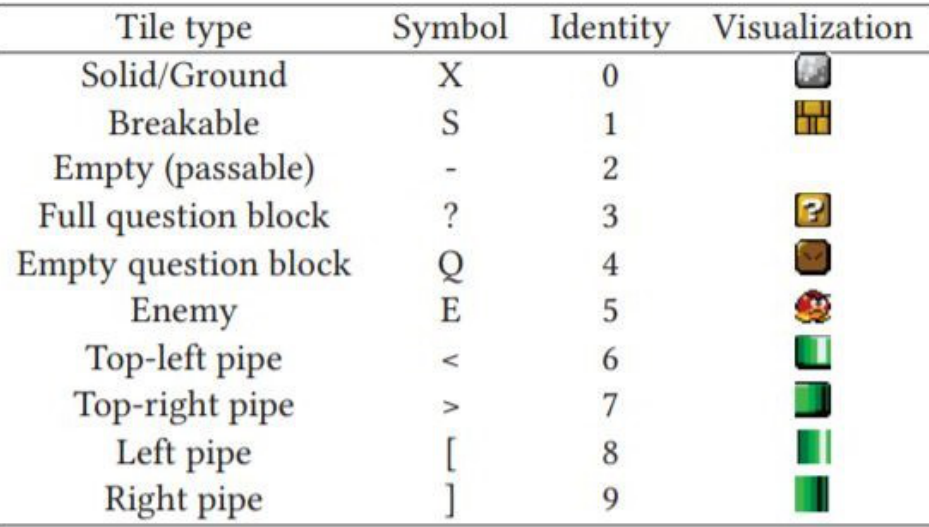
Figure 4. Tile encoding used for conversion into